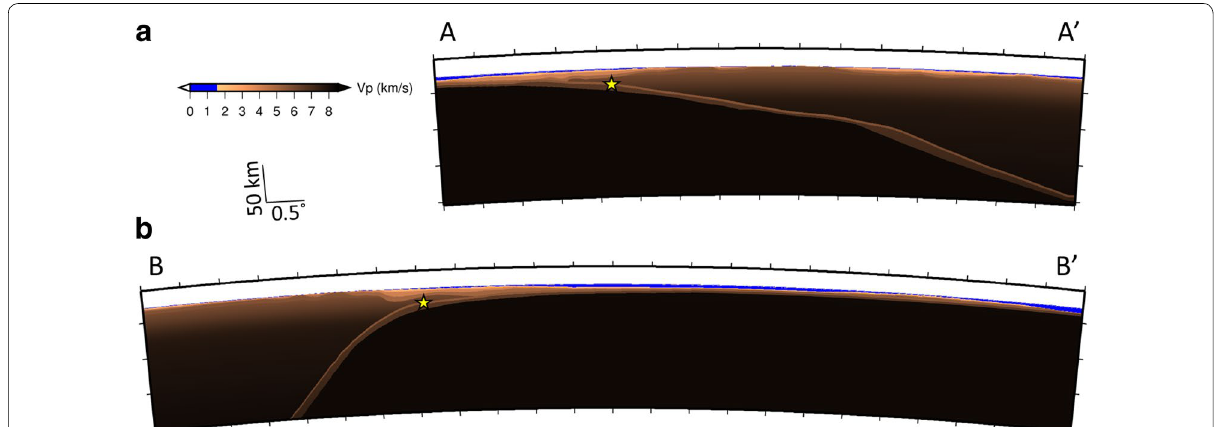
Fig. 9 Vertical cross sections of the structural model including the source a along A–A ′ (south–north) and b B–B ′ (west–east) lines in the right panel of Fig. 8. The color scale indicates P-wave velocity. A yellow star in each cross section indicates the source